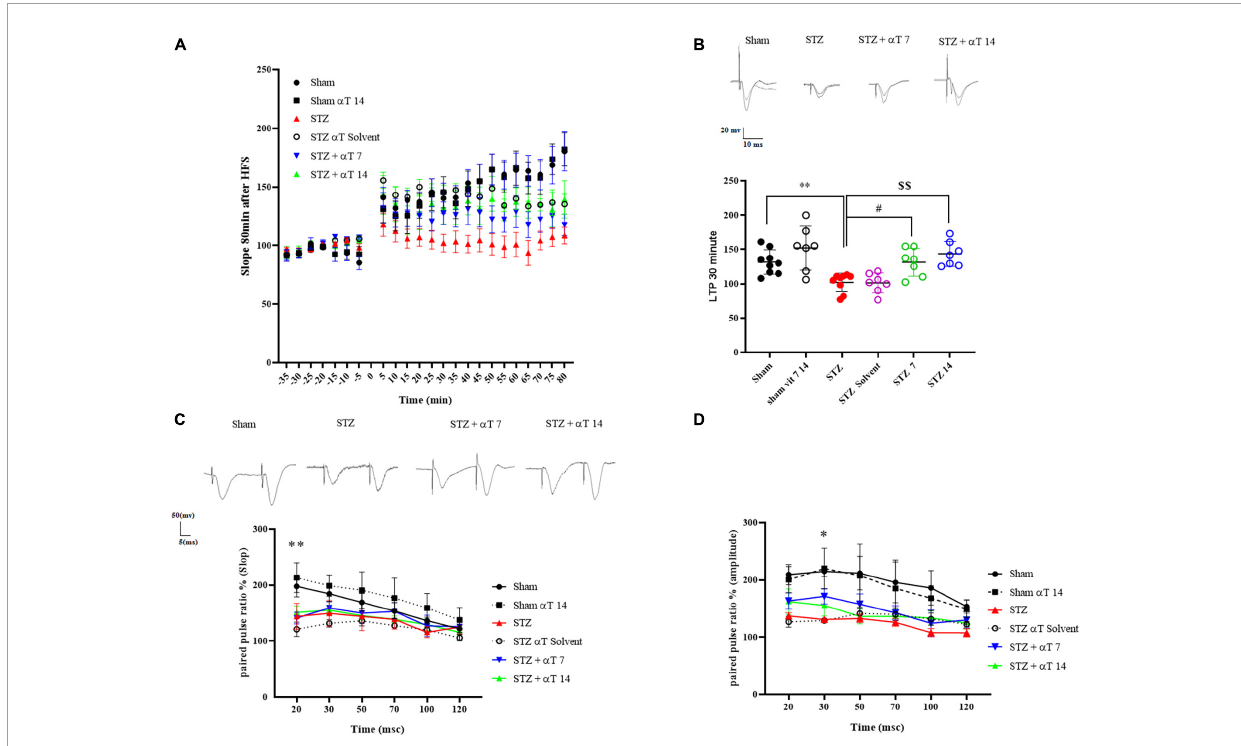
FIGURE5 Effect of α -Tocopherol therapy on neuronal synaptic plasticity in icv-STZ induced rats. (A) The normalized EPSP slope in different groups before and after HFS. In this respect, the EPSP slope was lower in icv-STZ animals, and they recovered in the α T-treated group. (B) Specimen recordings show changes in LTP recording for 60 min after HFS ( ∗∗ P < 0.01 STZ in comparison with sham; # P < 0.05 and $$ P < 0.001 STZ + α -Tocopherol 7 and STZ + α -Tocopherol 14 in comparison with STZ, respectively). The upper panel shows recorded traces from different groups. (C , D) The effect of icv-STZ on paired-pulse responses in the hippocampal dentate gyrus. At the intervals of 20, 30, 50, 70, 100, and 120, as shown by the field Excitatory Post-Synaptic Potential (fEPSP) slope ratio and Population Spike (PS) amplitude ratio (second response/first response ratio) ( n = 6 per group). There was a significant difference in the paired-pulse ratio of PS amplitude and slop in an icv-STZ group compared to the sham group, especially in intervals of 20 and 30 msec, respectively ( ∗ P < 0.05, ∗∗ P < 0.01 STZ in comparison with sham). Traces were recorded at the dentate gyrus at an inter-stimulus interval of 30